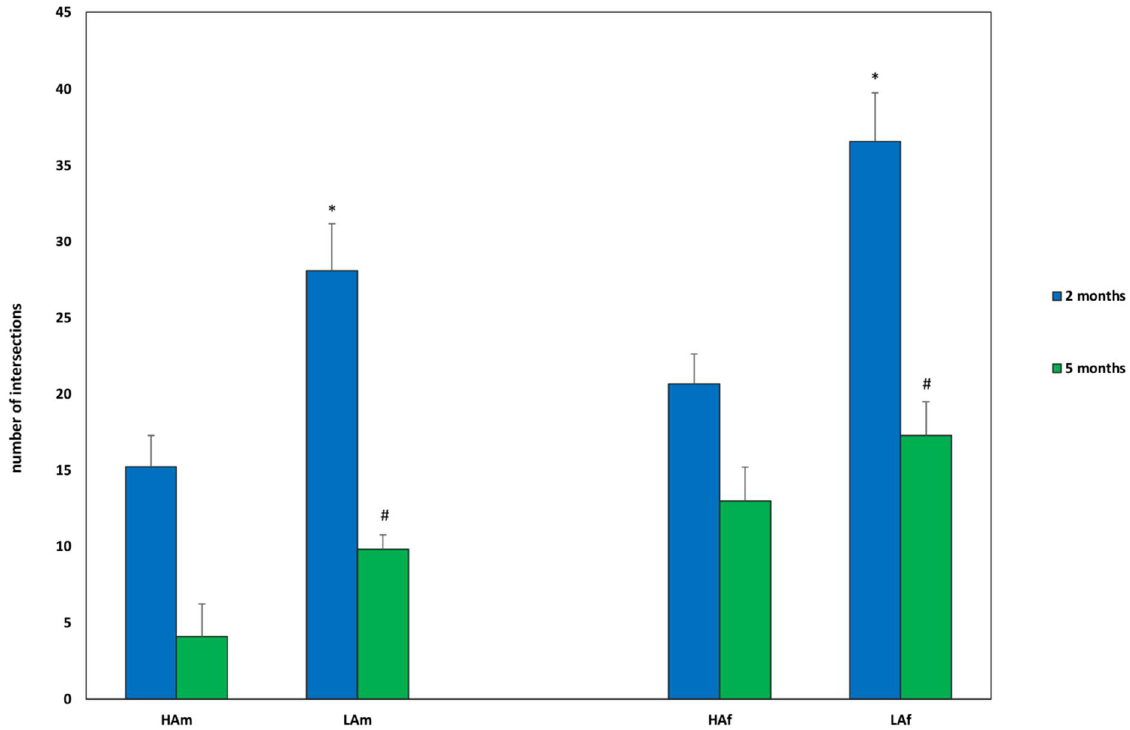
Figure 4. Number of intersections in an open field test. * p < 0.05 between HAm and LAm 2 month old and HAf and LAf 2 month old; # p < 0.05 between LAm 2 and 5 month and LAf 2 and 5 month old.